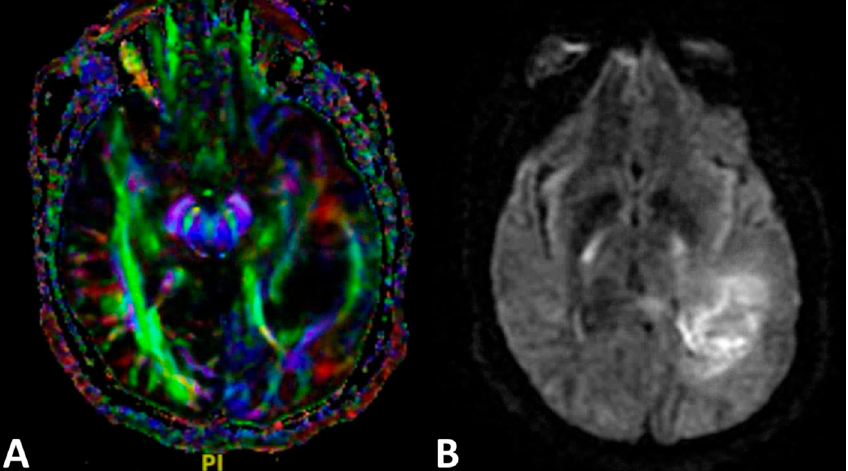
Figure 4. Diffusion tensor imaging. ( A ) Colored diffusion tensor imaging of a left temporal–parietal glioblastoma. Different neural fibers are displayed: transverse fibers (red), anteroposterior fibers (green), and craniocaudal fibers (blue) using tensor imaging features. ( B ) Noncolored diffusion tensor imaging of a glioblastoma.